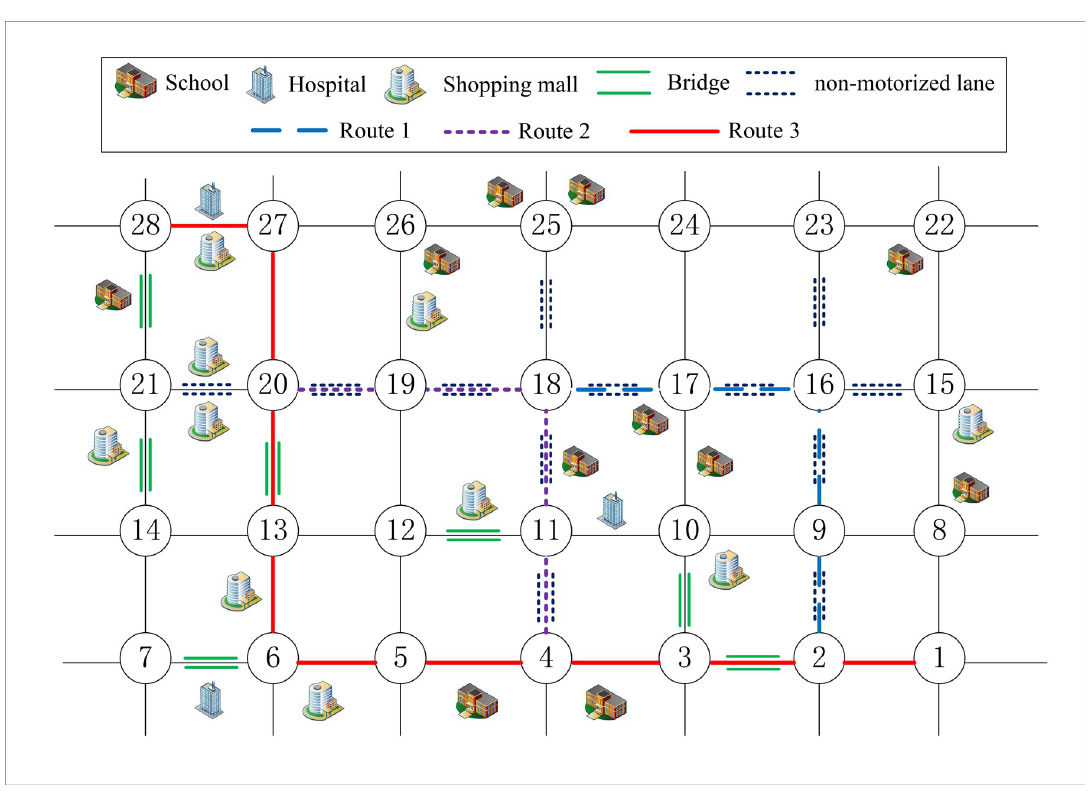
Fig 7. Route comparison